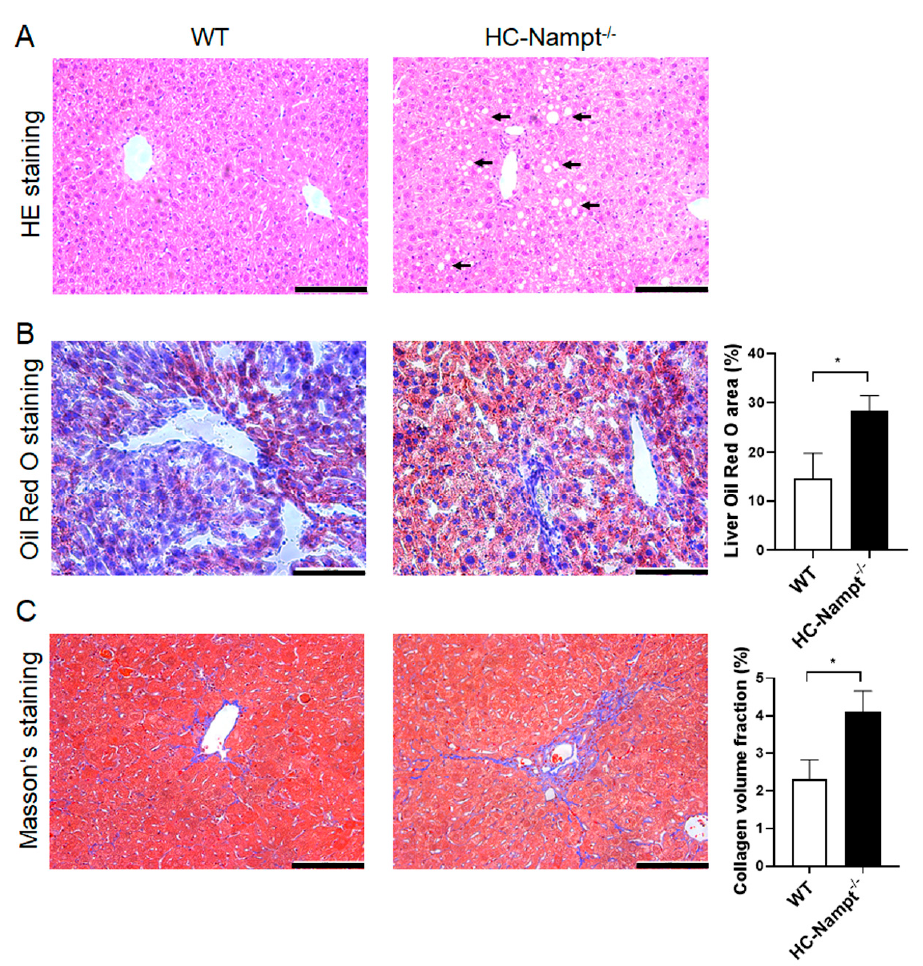
Figure 6. The effect of hepatic Nampt deficiency on liver histology in mice fed a HFD. ( A ) Repre- sentative images of HE staining on the liver of HC-Nampt -/- and WT mice after 10 weeks of HFD. ( B ) Representative images and quantitative analysis of oil red O staining on the liver of HC-Nampt -/- and WT mice after 10 weeks of HFD. ( C ) Representative images and quantitative analysis of Masson’s staining on the liver of HC-Nampt -/- and WT mice after 10 weeks of HFD. The scale bar = 100 µ m. Data are expressed as the mean ± SEM. n = 6 (WT) or 8 (HC-Nampt -/- ). In quantitative analysis, at least six visual fields were selected for analysis in each sample, and the average value was taken as the data of this sample. * p < 0.05 between two groups by two-tailed Student’s t -test.